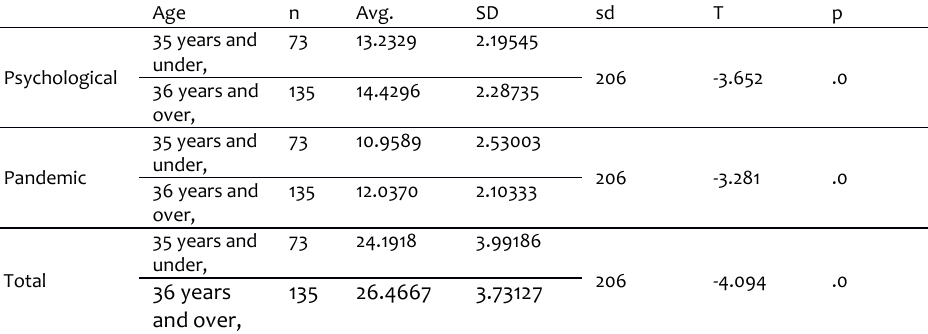
Table 2. The mean scores and t-test results of the reactions of the children to the pandemic according to the age of the parents